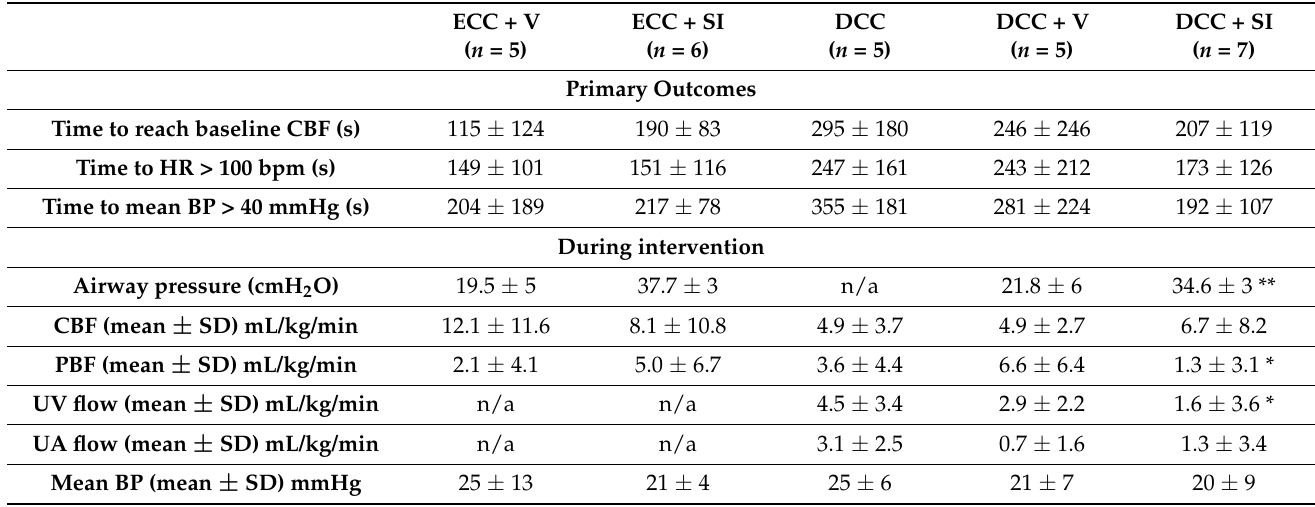
Table 2. Primary outcomes and hemodynamic parameters during the intervention period.